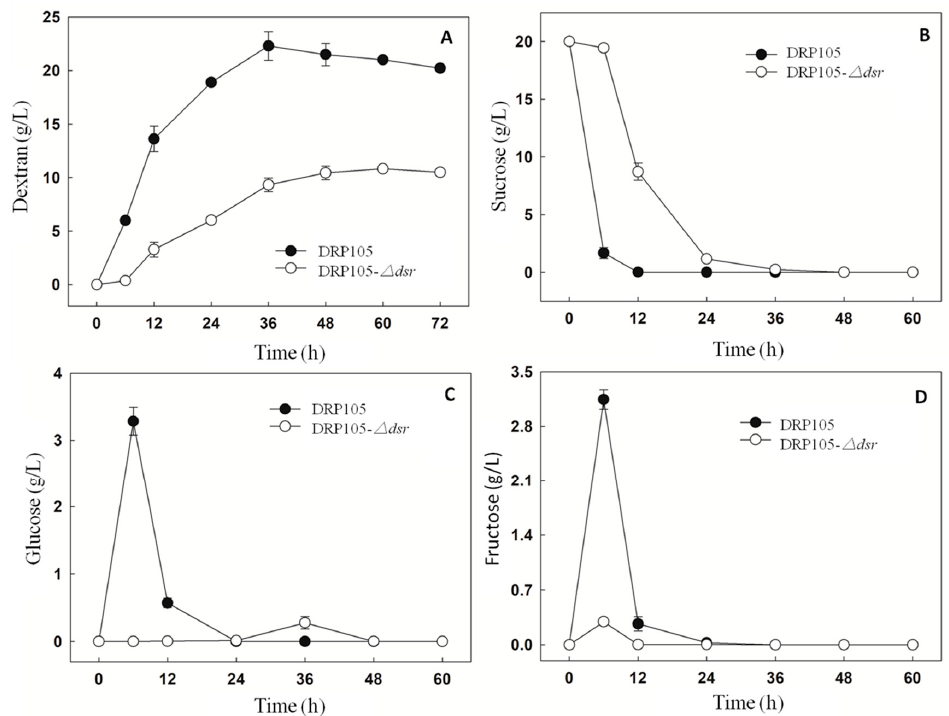
Figure 10. The carbohydrate content during Leu. mesenteroides DRP105 and Leu.